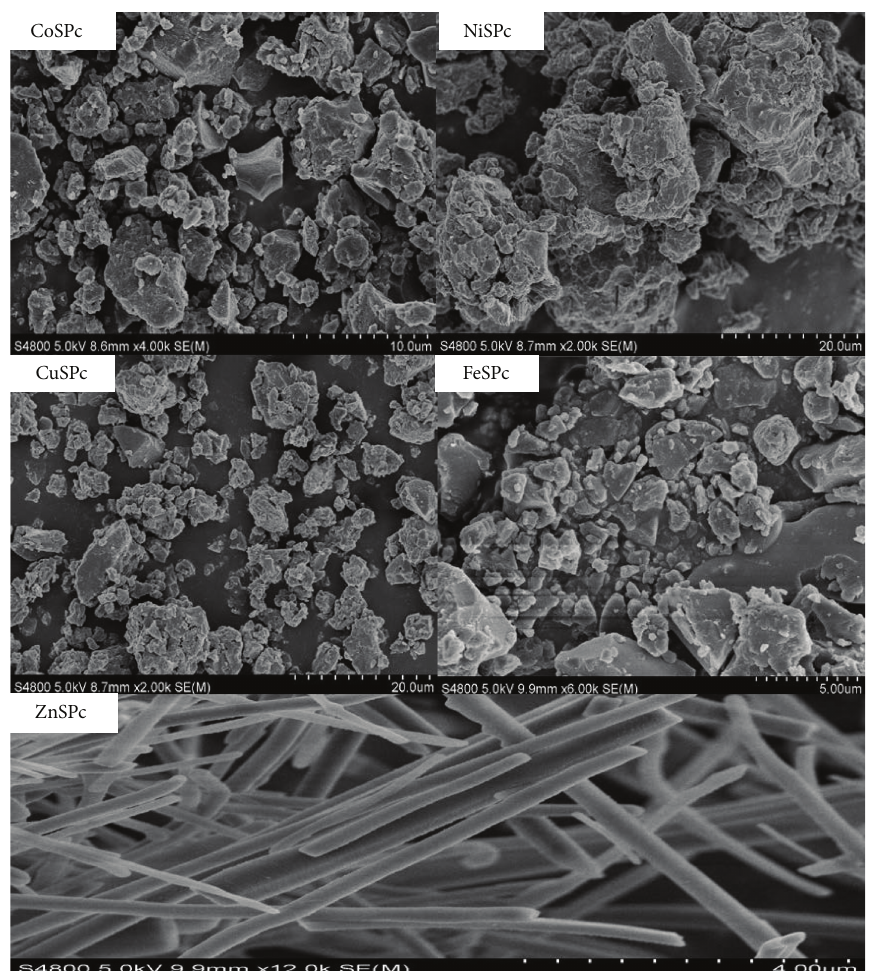
Figure 3: The electron micrographs of the five sulfonated phthalocyanine metals.